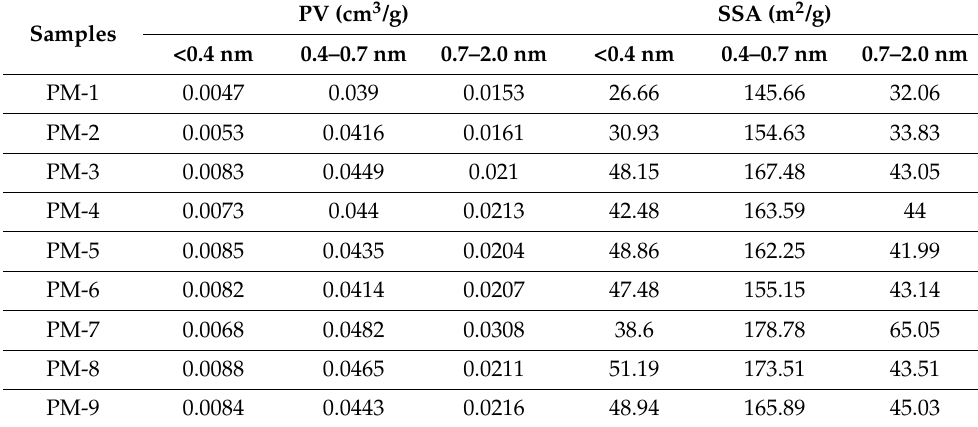
Figure 9. Distributions of the PV and SSA results of different sizes of micropores. ( a ) PV; ( b ) SSA. Table 5. PV and SSA results of different sizes of micropores. Table 5. PV and SSA results of different sizes of micropores.